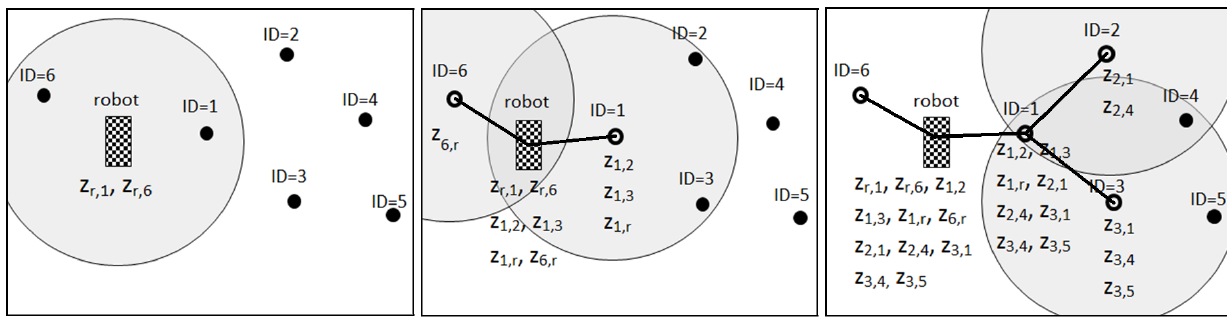
Figure 2. Examples of measurement gathering with: IDL = 0 ( left ); IDL = 1 ( center ); and IDL = 2 ( right ). Lines represent the interchange of forward (and backward) messages. Grey circles represent sensing zones of the deepest beacons for each